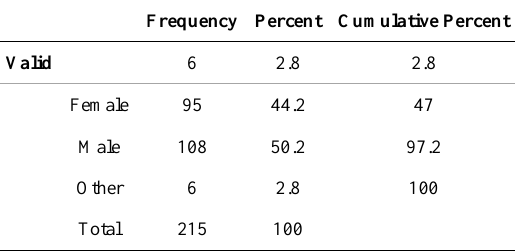
Table 3. Gender (Questionnaire